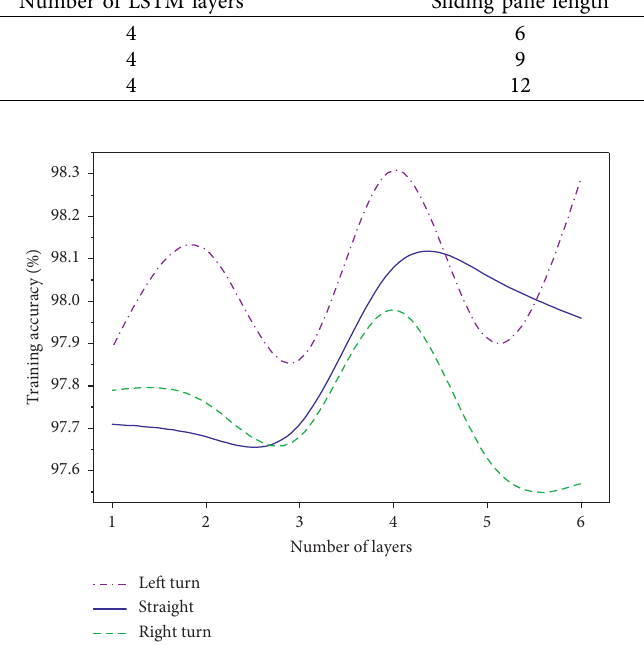
Figure 8: Relationship between the number of LSTM layers and the training accuracy.